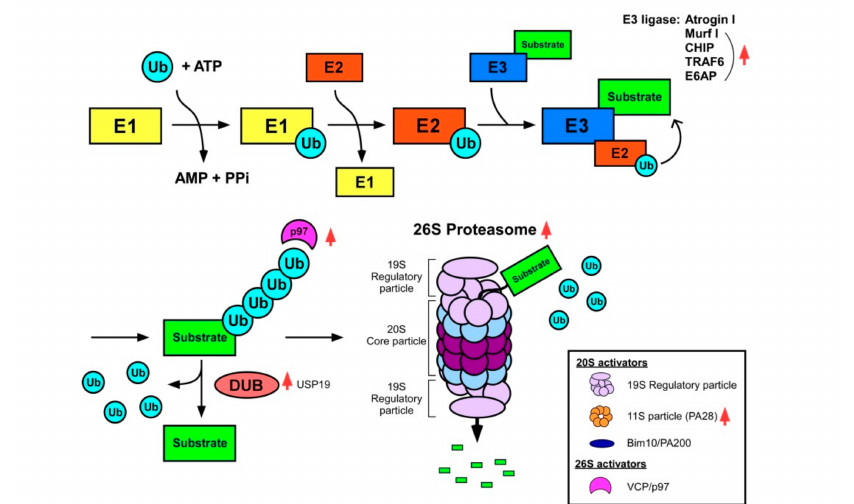
Figure 2. A hypothetical model depicting the changes in proteasome (red) and autophagy (blue) activity, as well as in the level of cellular oxidized proteins (potentially indicating overall cellular oxidative stress; black) in muscle. The thresholds for the onsets of muscle atrophy and sarcopenia are presented as the green vertical lines. In this model, the occurrence of sarcopenia is preceded by accumulation of oxidized proteins and subsequent impairment of the ubiquitin-proteasome system (UPS) and autophagy-lysosome system (ALS). The induction of proteasome activity (as well as autophagic flux) under the physiological conditions possibly reflects the adaptive response to oxidative stress although controversies exist about the changes of proteasome and autophagic flux during aging. The feedback regulatory circuit between the two proteolytic systems and the regulatory mechanism contributing their balance during sarcopenia remains to be determined.